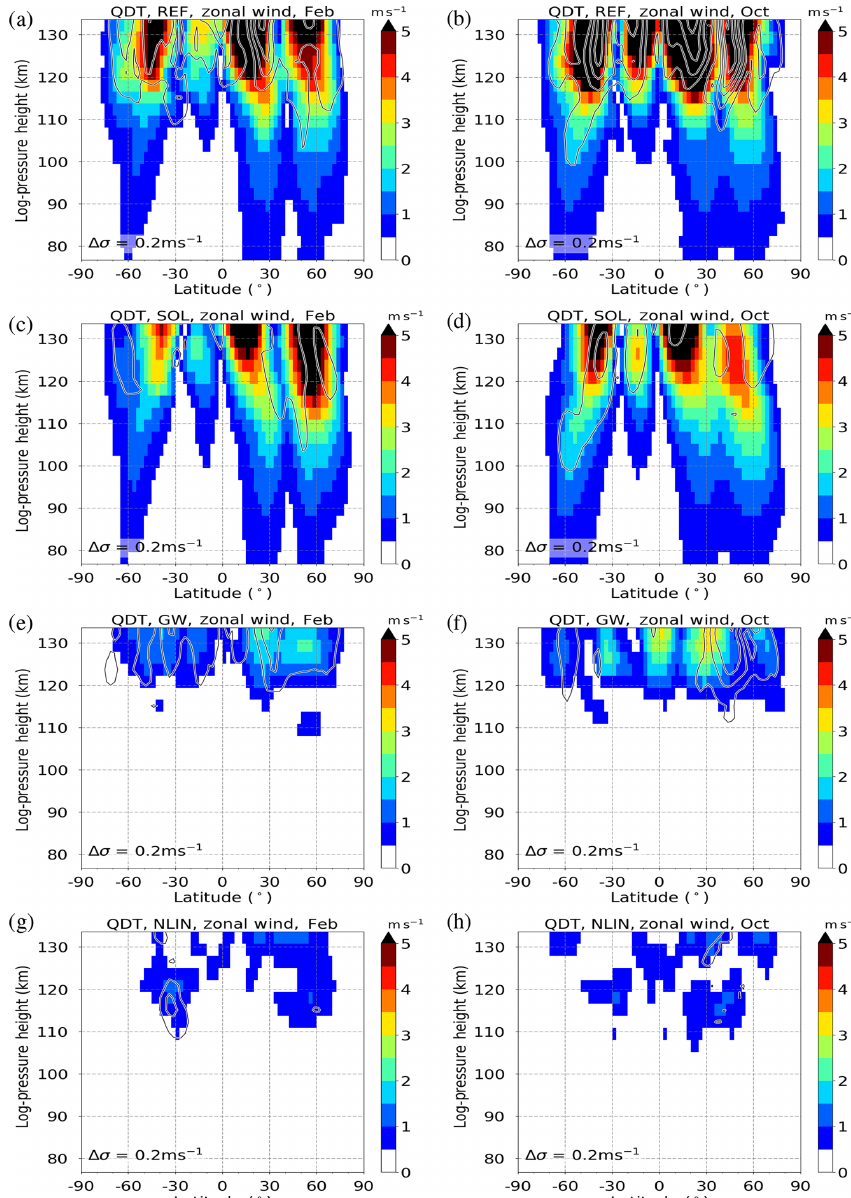
Figure 7. Same as Fig. 5 but for QDT zonal wind